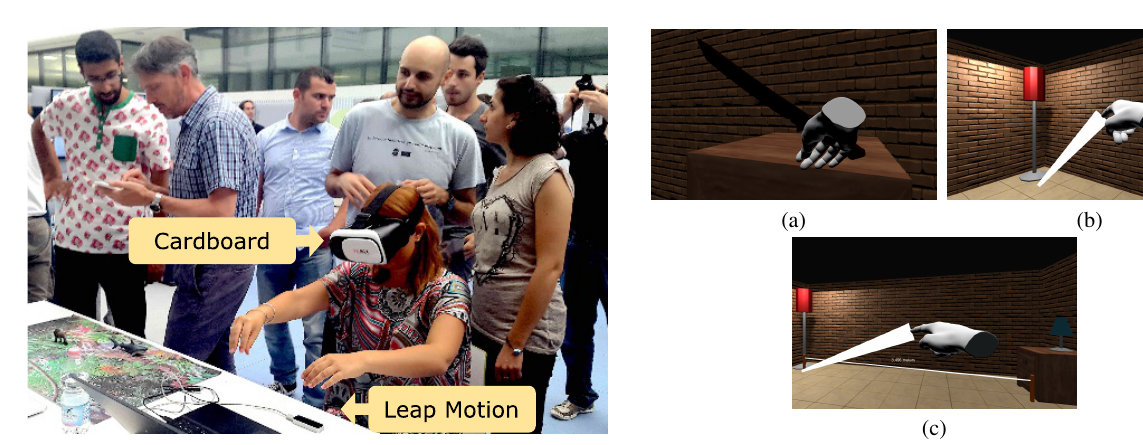
Figure 2. A single user experiencing VR with Leap Motion con- nected to Cardboard via WiFi. The picture was taken during the Research Open Day of the ICT centre in Fondazione Bruno Kessler. Although the communication between the two devices delay-free hand-based interaction with virtual objects.